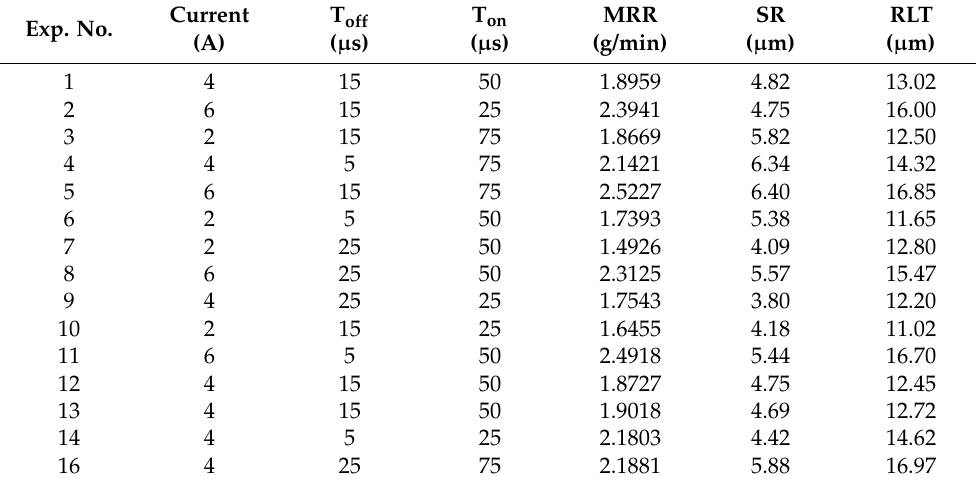
Table 3. Experimental plan as per RSM of BBD and readings of MRR, SR, and RLT. Exp.